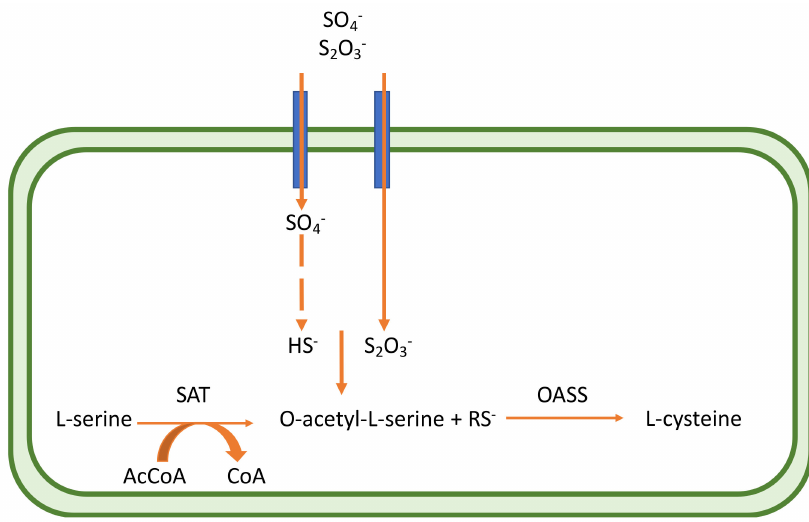
Figure 6. Schematic representation of the Cysteine-synthase-complex (CSC) within bacterial cell; RSAP begins with the transportation of sulfate inside the cell, followed by its reduction to bisulfide. This process is highly energy-consuming and is tuned to cellular needs. Bacteria find sulfur in the form of sulfate in the environment and actively transport it through plasma membrane. After the reduction of sulfate to bisulfide, the latter is incorporated into cysteine by a member of a large enzyme family, known as cysteine synthase complex (CSC). The CSC is composed by the enzyme serine acetyl transferase (SAT) and O-acetylserine sulfydrylase (OASS), which catalyzes the last step of cysteine biosynthesis.